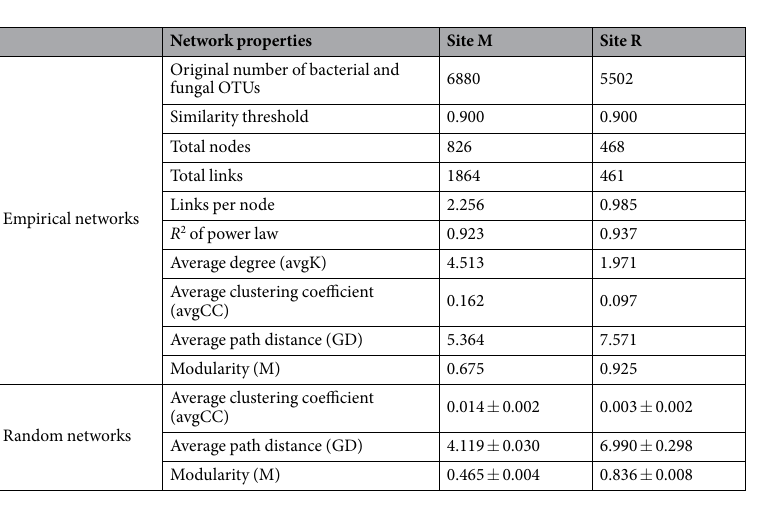
Table 3. Major network characteristics of bacterial and fungal communities found at the deciduous forest site M (545–570 m asl) and the coniferous forest site R (1,724–1,737